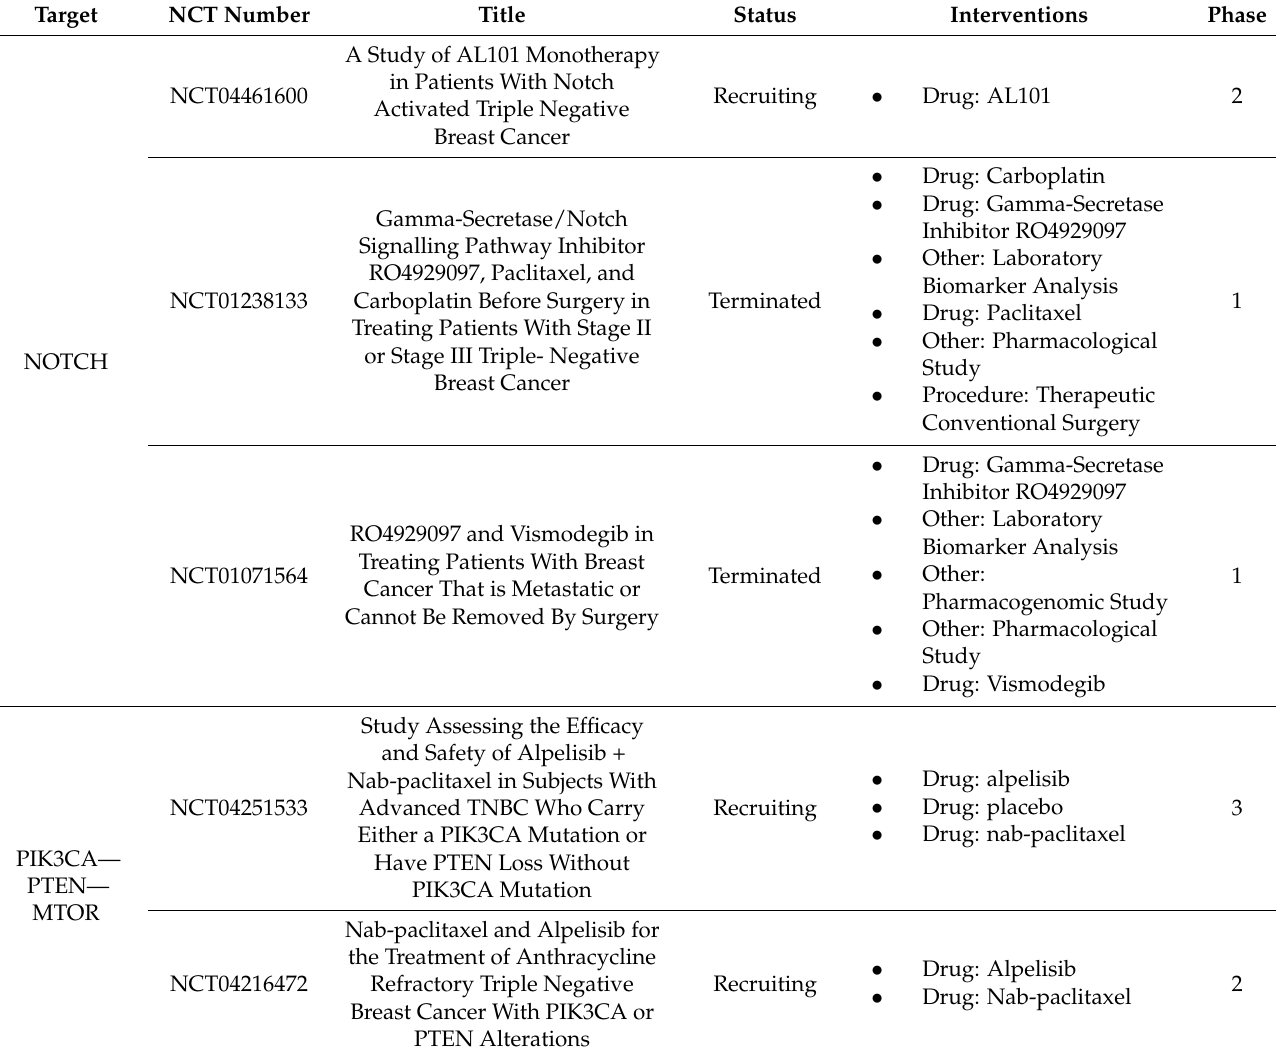
Table 1. Comprehensive overview of currently ongoing clinical trials evaluating the pathways expressed in triple negative mesenchymal breast cancer as targets for